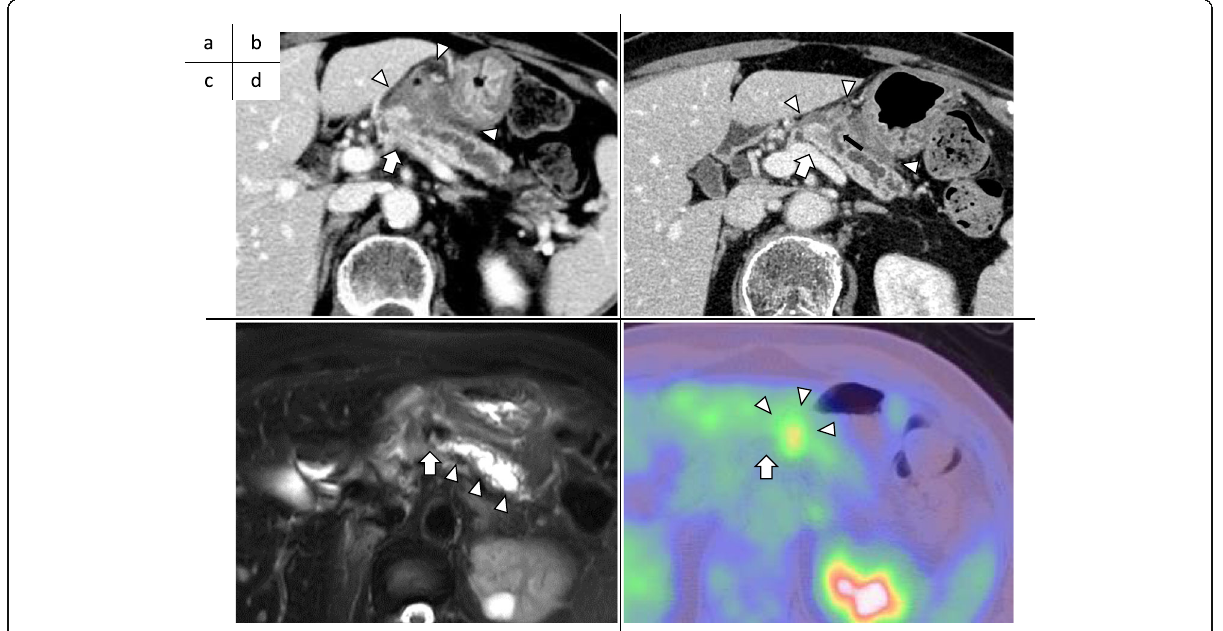
Fig. 1 Imaging findings. a Abdominal multidetector-row computed tomography (MDCT) at the referral hospital. A hypovascular tumor was present in the body of the pancreas (arrow), and the distal pancreatic duct was dilated. In addition, a slightly low-density area (LDA) was found to be spread over the ventral side of the pancreas (arrowhead) and touching the stomach. b MDCT images obtained 2 months later at our hospital. There was no significant change in the tumor size (arrow) or pancreatic duct dilatation, but the LDA at the ventral side of the pancreas had shrunk (arrowhead). The two-tone duct sign and cork-of-wine-bottle sign were observed (arrow). Retrospective examination revealed findings that seemed to indicate the rupture of the main pancreatic duct (MPD) and the formation of a fistula extending outside of the pancreas (black arrow). c T2-weighted magnetic resonance image taken at our hospital. Constriction of the MPD (arrow) and distal MPD dilatation (arrowhead) was observed, but the tumor was unclear. d Positron emission tomography-computed tomography taken at the referral hospital. Weak accumulation of fluorodeoxyglucose was present at the ventral side of the pancreas, corresponding to the LDA on MDCT (arrowhead); however, no apparent accumulation was noted in the tumor